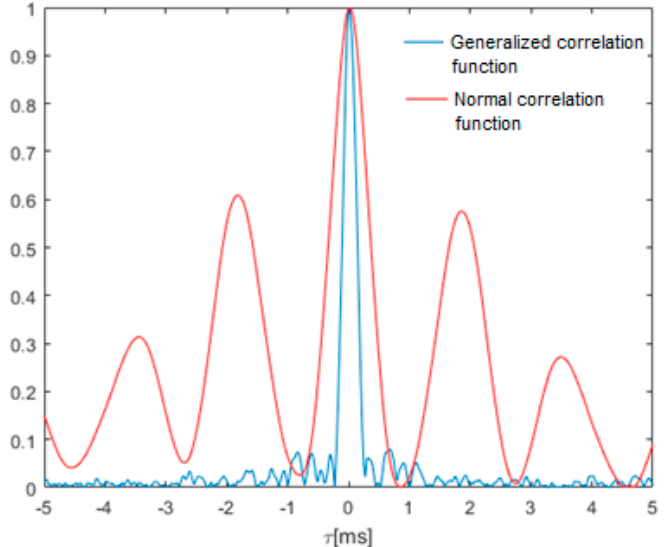
Figure 15. Comparison of the waveforms of the normal and generalized correlation function of the audio signal from an aviation radio.